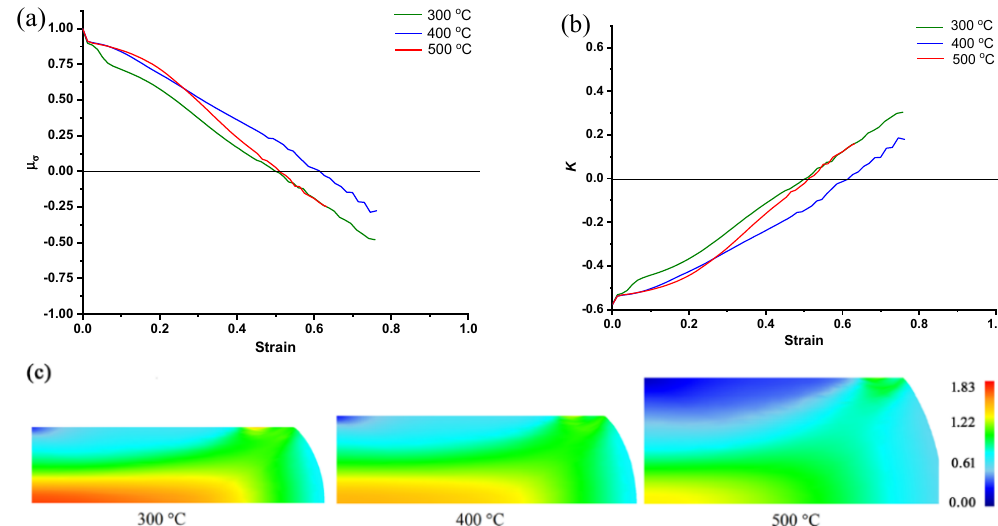
ε Figure 12. The strain ( ) dependence of accumulated damage the zone near the side surface at 300, 400, and 500 °C (see Figure 2).